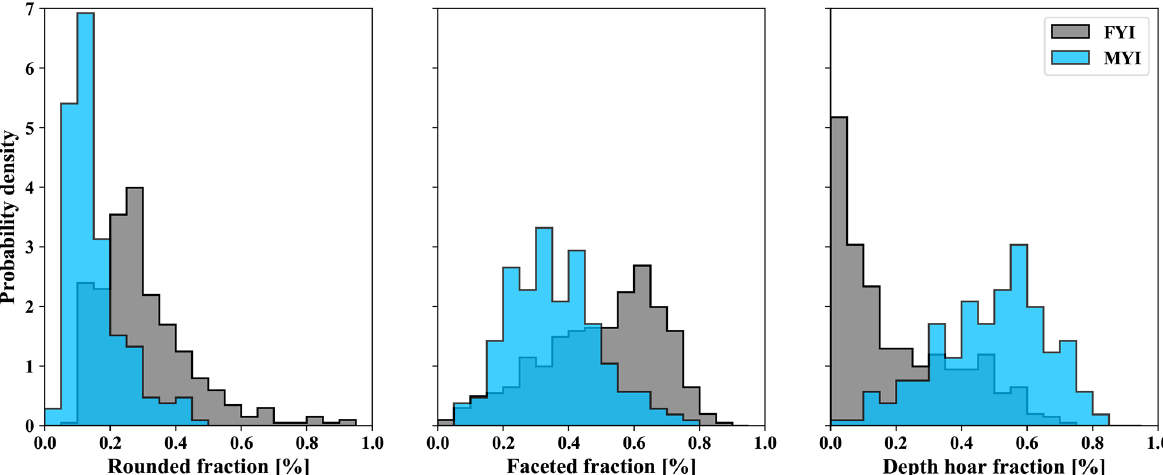
Figure 8. Fractional snowpack composition by rounded, faceted, and depth hoar layers from the SMP profiles on first-year (FYI) and multi- year (MYI) sea ice. Classification methods for the SMP are described in Sect.